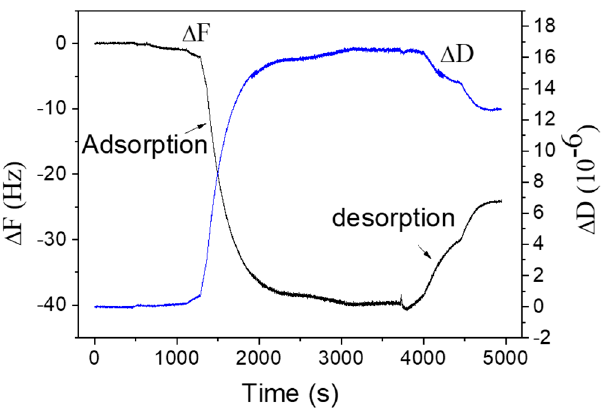
Figure 13. Δ F and Δ D of quartz in the solution after adding MDA and Q[7] successively. Figure 13. ∆ F and ∆ D of quartz in the solution after adding MDA and Q[7] successively.